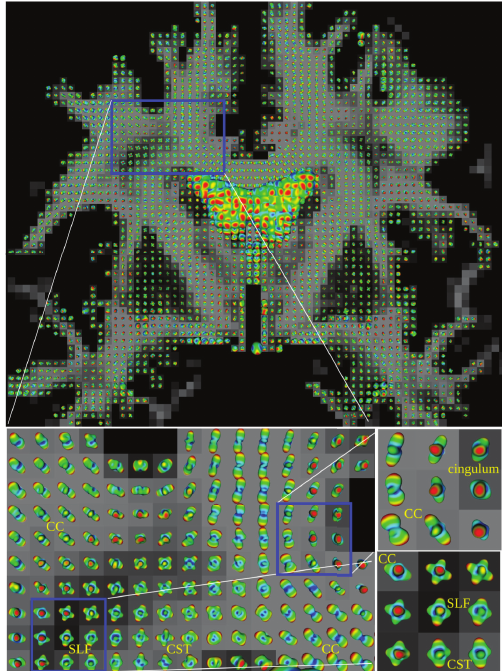
Figure 4: Real dataset experiment. A coronal slice with the Pr (7) 4,4 . The main zoom contains regions where three fiber bundles, namely, the CC, the CST, and the SLF intersect. The upper secondary zoom highlights the crossing between the CC and the cingulum due to partial voluming. The lower secondary zoom shows the main voxels with three peaks that correspond to the crossing between the CC, the CST, and the SLF. Table 1: Computation time. A 30 × 30 voxel slice of the synthetic dataset was used for computations. The numerical Fourier Trans- form was performed on a coarse spherical mesh with 162 vertices to compute the angular profile of the EAP. The proposed analytical approximate EAPs were computed on both the coarse mesh and a finer spherical mesh with 2562 vertices. The analytical formulation is clearly advantageous. Numerical